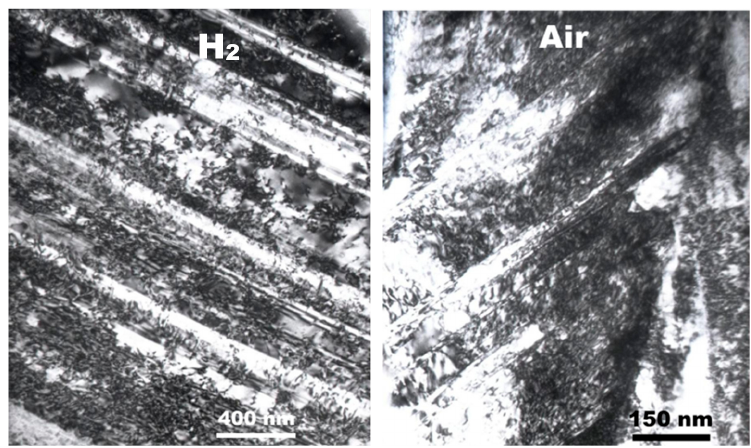
Figure 3. Planar dislocations formed at the fracture surfaces of a 316 SS after tensile tests in hydrogen and air, respectively (reproduced from [8] with permission from BH Choe, 2019). Metals 2018 , 8 , x FOR PEER REVIEW